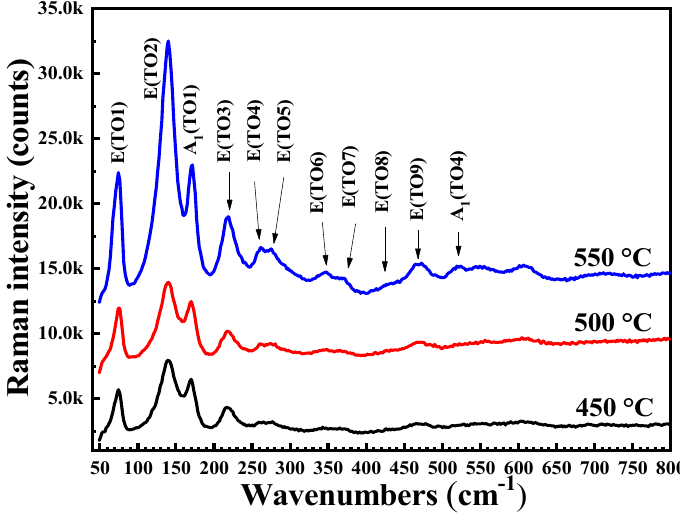
Figure 2. Raman spectra of BFO thin films annealed at various temperatures in an air atmosphere.